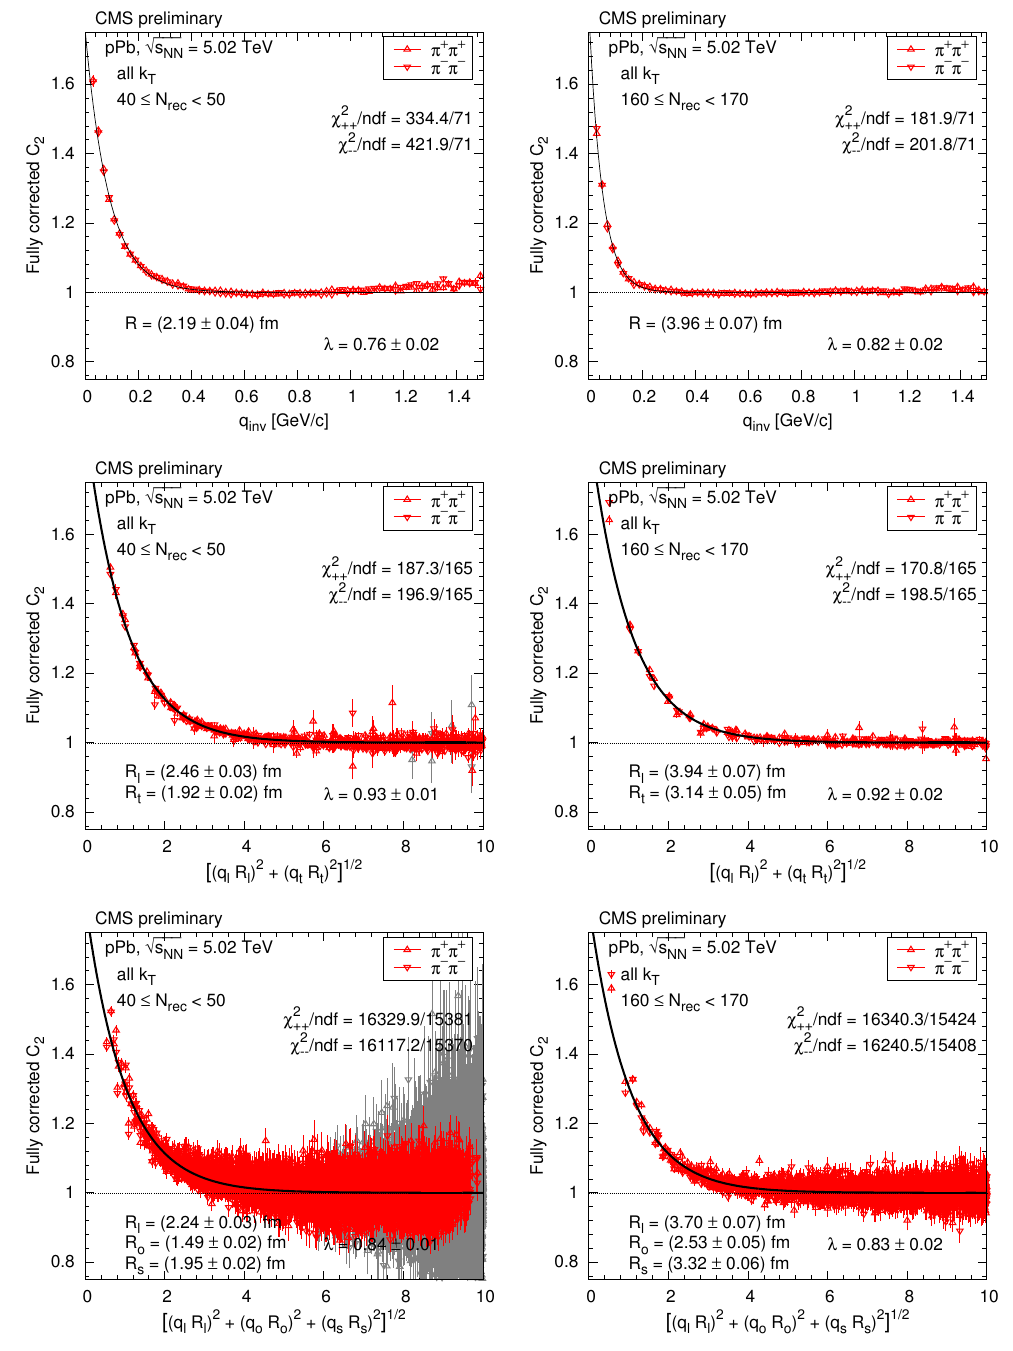
Figure 3. The like-sign correlation function of pions (red triangles) corrected for Coulomb interaction and cluster contribution (mini-jets and multi-body resonance decays) as a function of q inv or the combined momentum, in some selected N rec bins for all k T [8]. Points with statistical uncertainty higher than 10% are plotted with light grey color. The solid curves indicate fits with the exponential Bose–Einstein